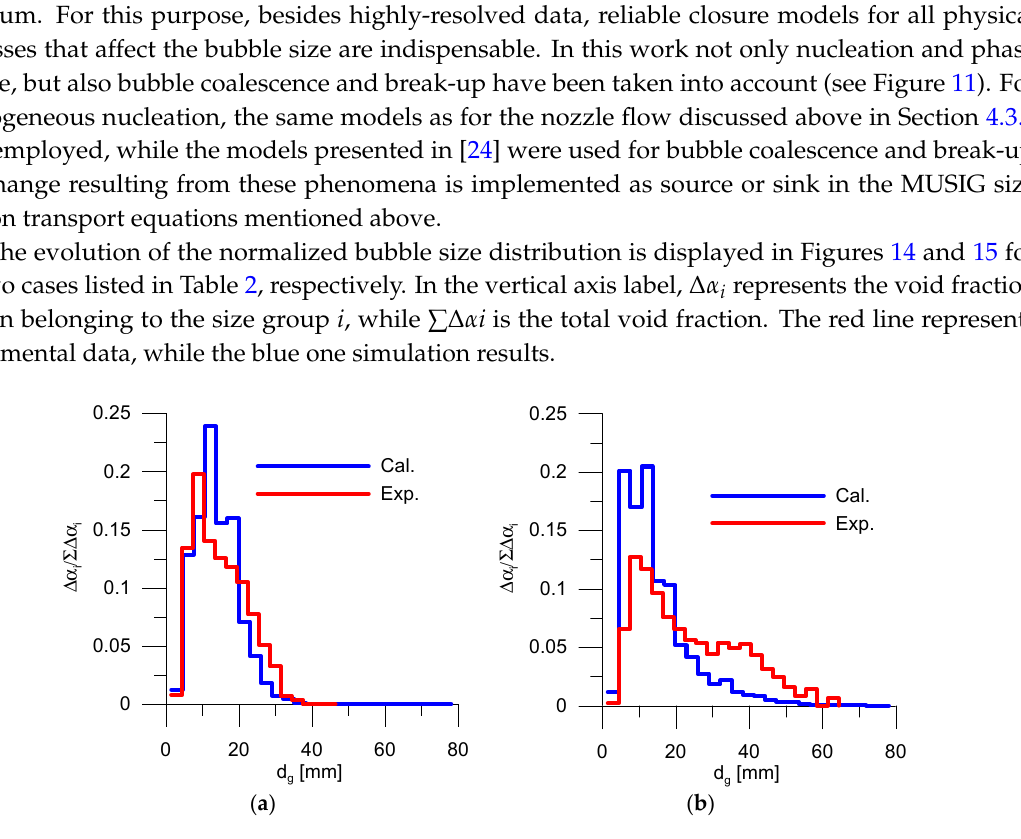
Table 2. Experimental conditions of the investigated test cases.